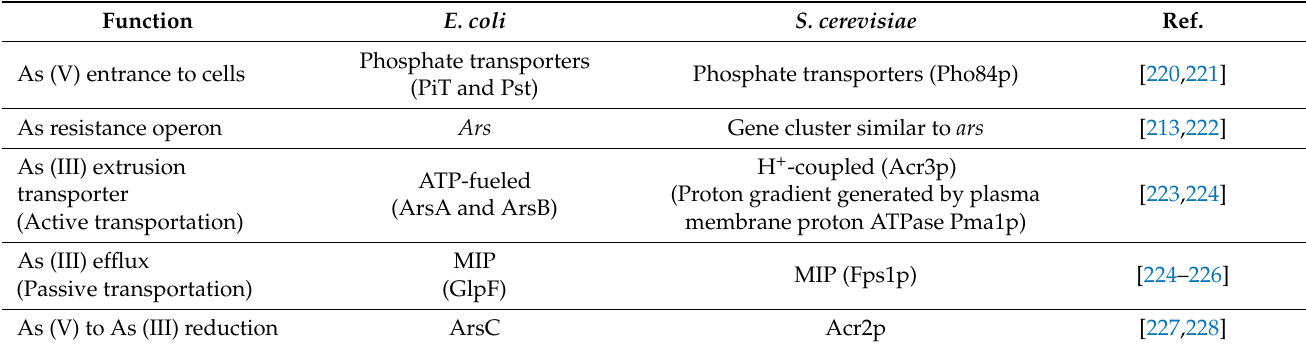
Table 2. Comparison of arsenic transportation in bacteria and